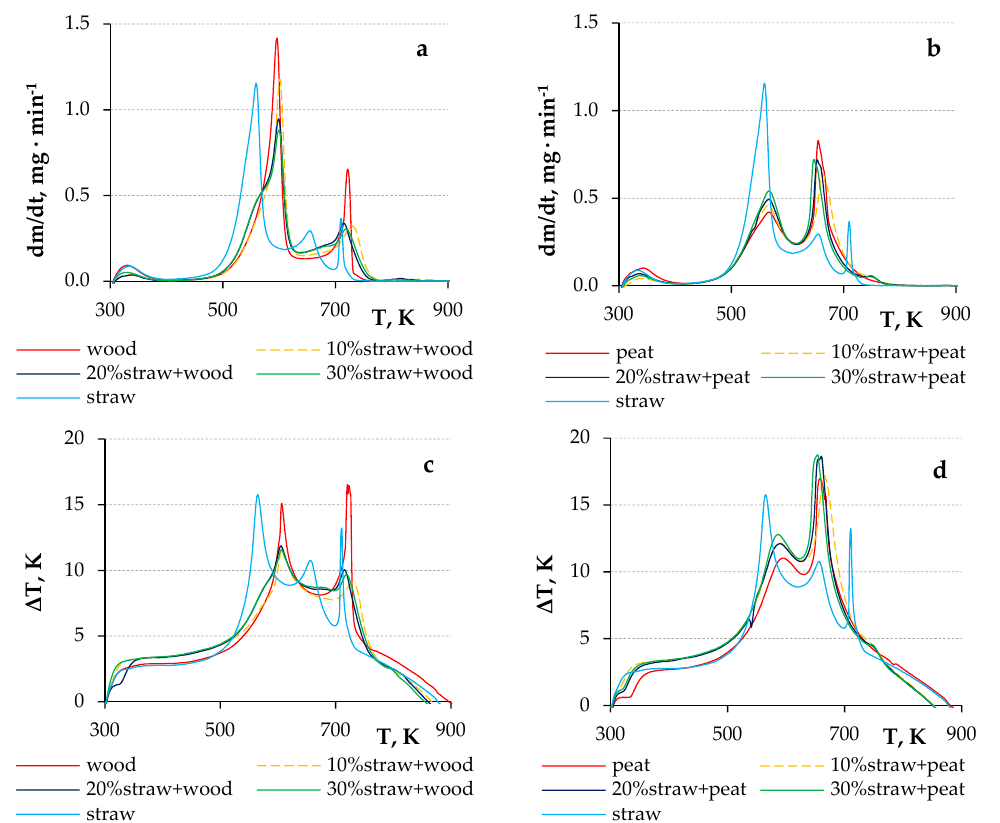
Figure 2. Results of TGA and DTA analysis at thermal decomposition and combustion of straw mixtures with wood ( a , c ) and with peat ( b , d ).